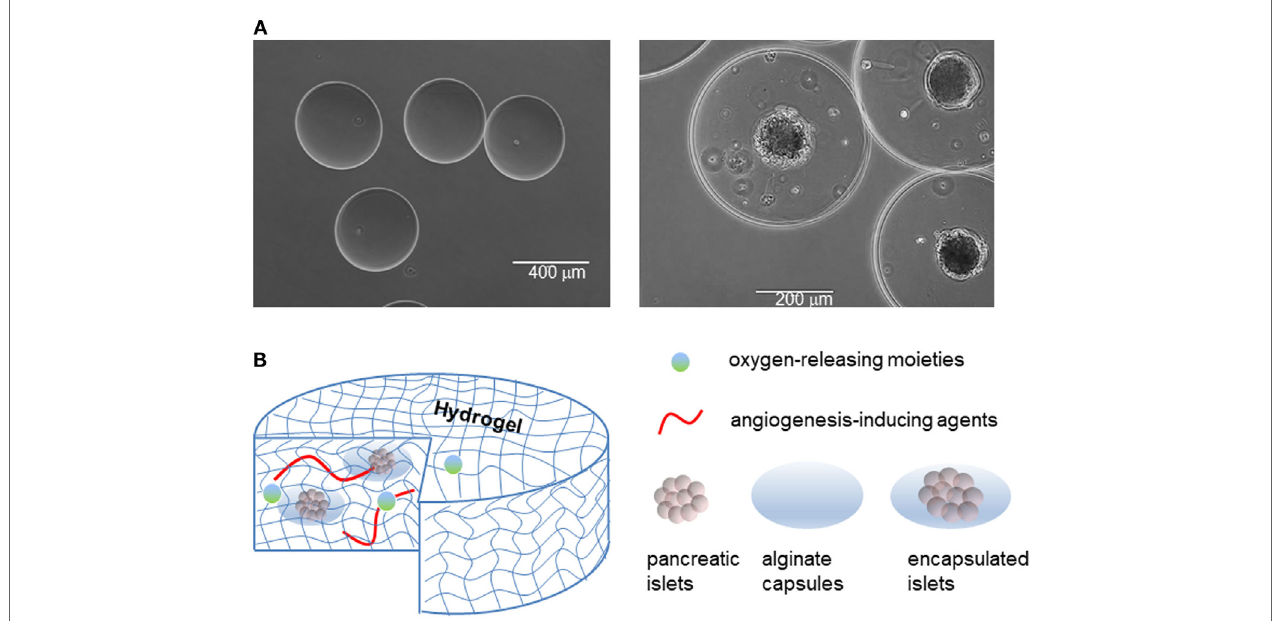
FigURe 5 | Islet encapsulation and their integration in medical devices for implantation in patient. (A) Empty alginate capsules (left panel), and alginate capsules containing islets (right panel). (B) Examples of devices to contain naked or encapsulated islets and features that enhance their integration with the